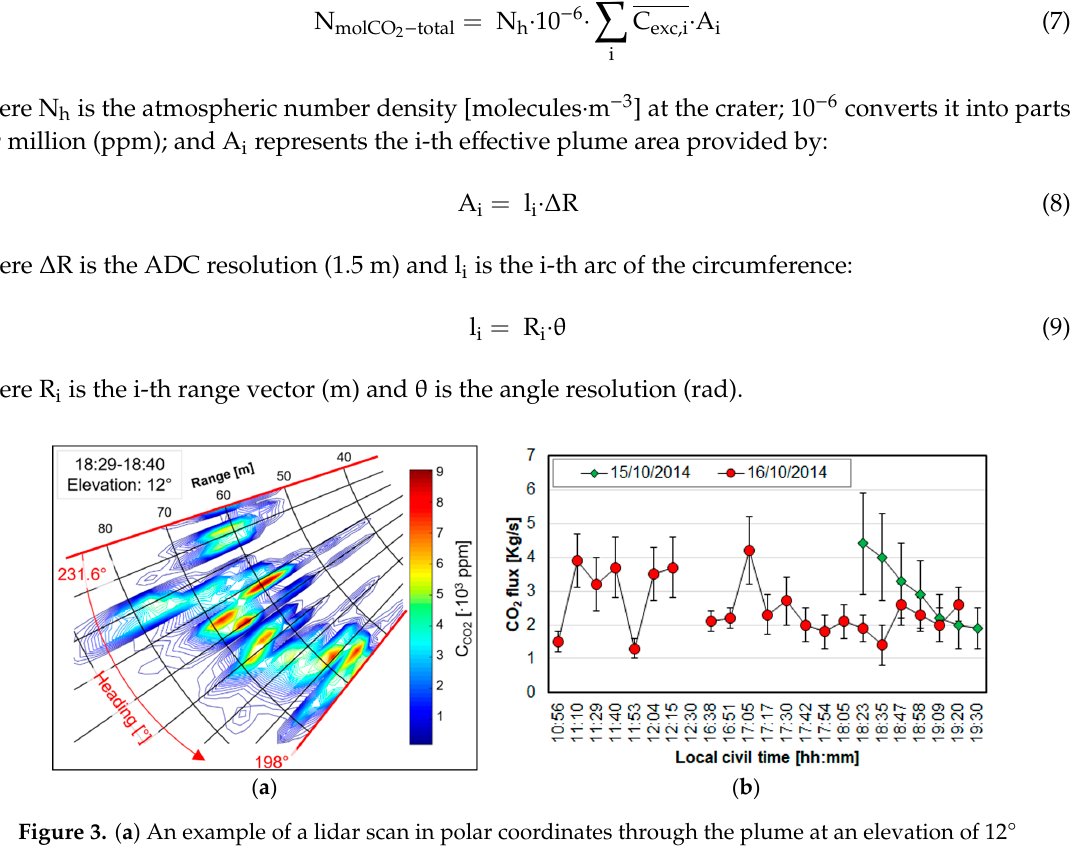
( a ) ( b ) Figure 4. ( a ) In-plume CO 2 concentration map acquired on 26 June 2015 at Stromboli. Carbon dioxide concentration varies as a function of increasing altitude (on the left of the map) and elevation (on the right of the map). The superimposed grey points represent the vertical wind profile retrieved by BILLI in the same dataset. Here, the mean value of the wind velocity was found about 1.3 m/s. The x-axis error bar is the weighted average standard uncertainty of wind velocity, equal to 0.52 m/s. Instead, the error bar on the y-axis represents the altitude halfwidth between adjacent regions (A, B, C, and D) [40]). This figure has been obtained by combining Figures 4 and 8